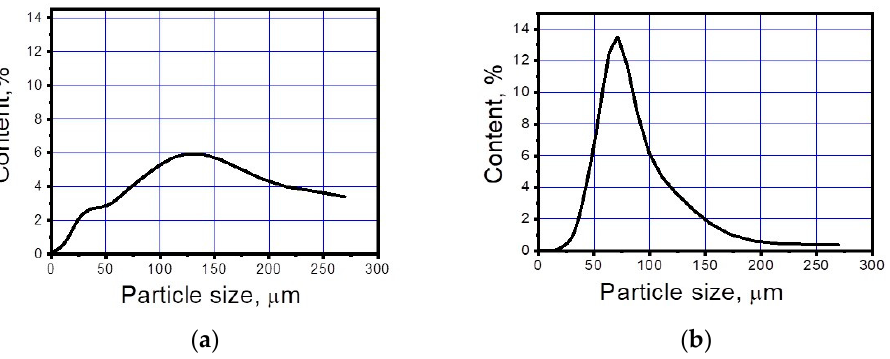
Figure 2. Size distribution of the magnetite particles synthesized ( a ) without a stabilizer; ( b ) using sodium stearate as the stabilizer.